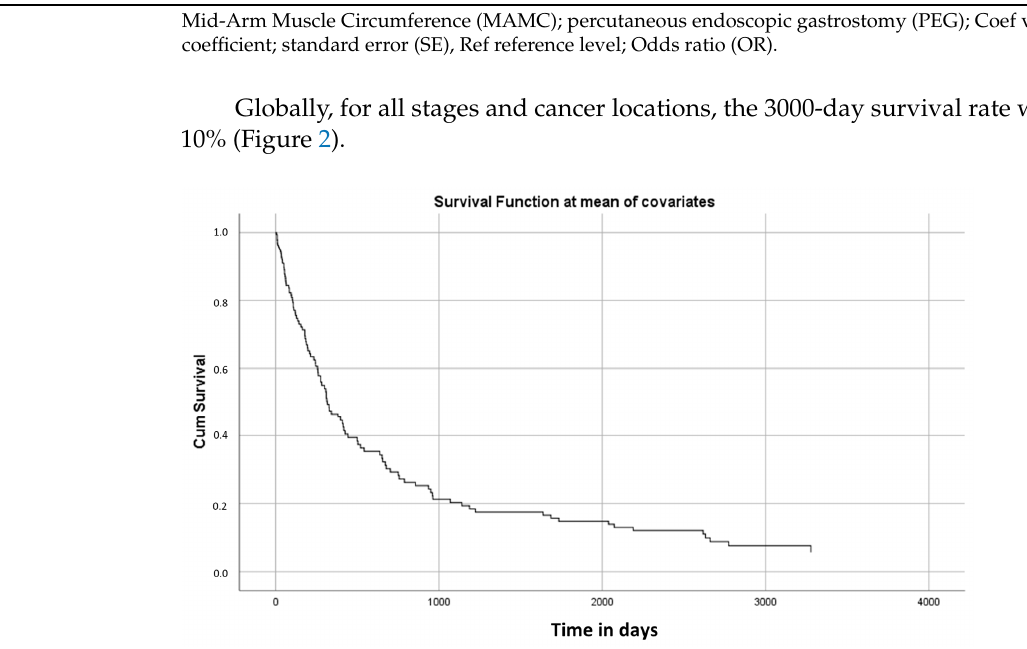
Figure 2. Kaplan–Meier survival curve in all stages and cancer